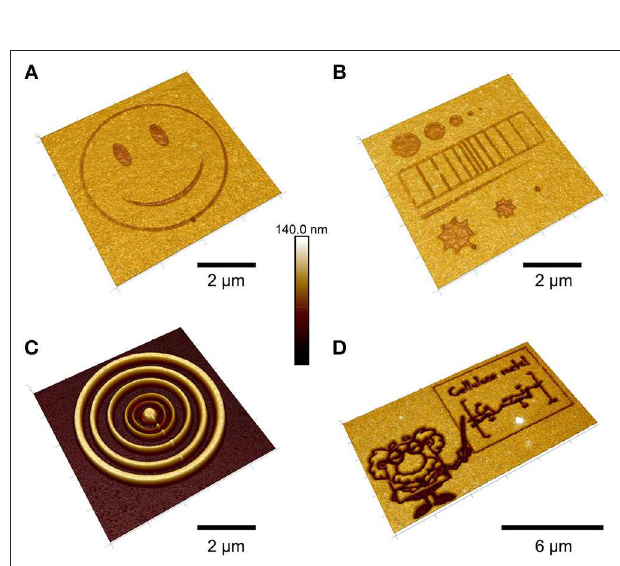
FIGURE 8 | AFM height images of TMSC films treated with an electron beam (A,B,D) and subsequent development with toluene (C) [Reproduced from Ganner et al., 2016 under the terms of the Creative Commons Attribution (CC-BY) license].